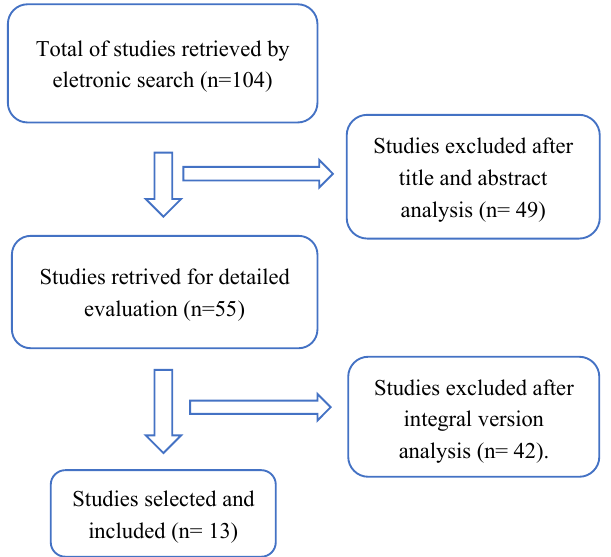
Figure 2. Flow diagram of article selection process through the scoping review.